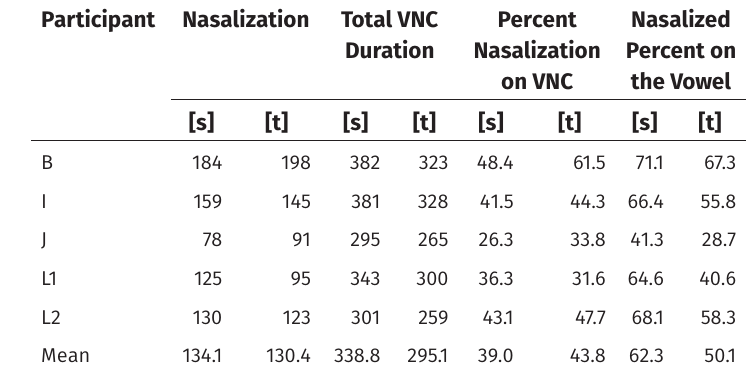
Table 5: Mean duration (ms) and nasalized portions (%) to the total duration of the VNC sequence for each participant and averaged over